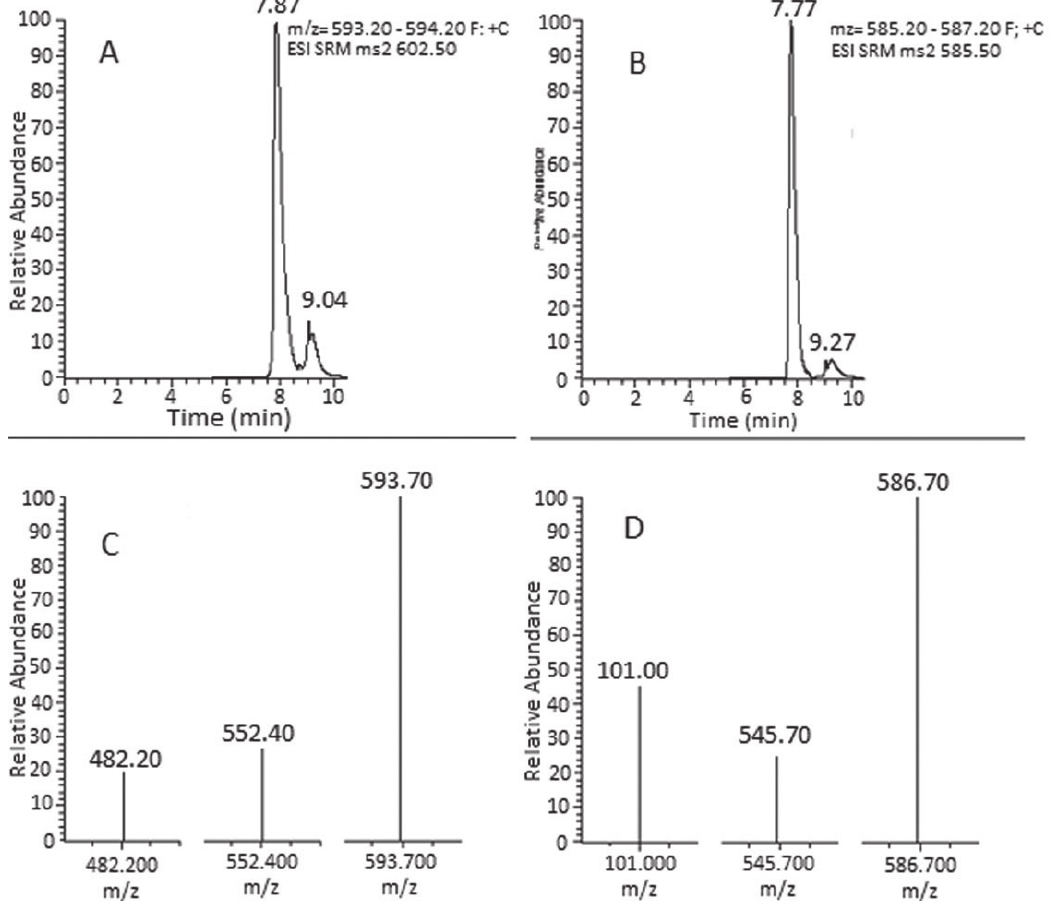
FIGURE 1 ‑ Chromatograms of standard solutions: Polymyxin B1 (A) and Polymyxin B2 (B). Mass transitions from Polymyxin B1 (C) and Polymyxin B2